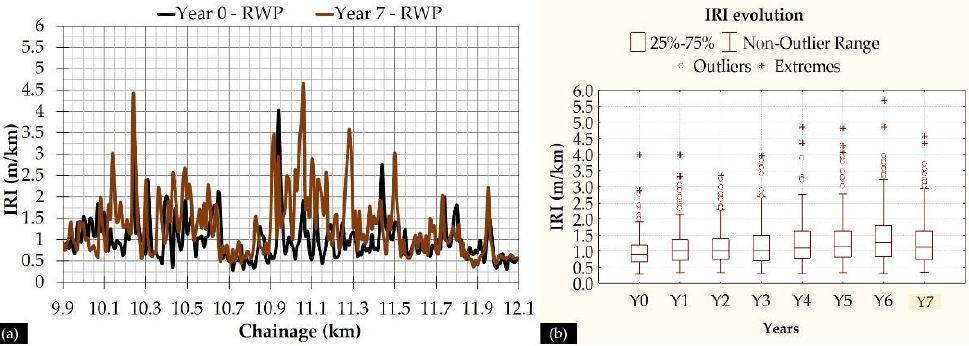
Figure 6. ( a ) Roughness profile along the pavement, and ( b ) roughness evolution yearly in the form of boxplots. To further proceed with the integration of roughness and deflectometric data, it was decided to group IRI values of 200 m length (100 m before and 100 m after the exact location of FWD test). Eleven distinct subsections were defined, so that the midpoint of each subsection matches the exact location of the FWD test. Descriptive IRI statistics (only for RWP) are shown in Figure 7 in the form of boxplots for years 0 and 7. The line inside each boxplot refers to the median. Increased variability is again observed, even in the subsections of 200 m, considering the form of boxplots as well as the Coefficients of Variation (CV) at each subsection, shown in Table 4.